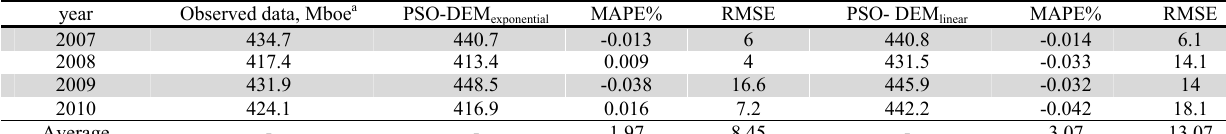
Investigation of test data prediction compared with simulated values with particle swarm optimization algorithm (by Mtoe)